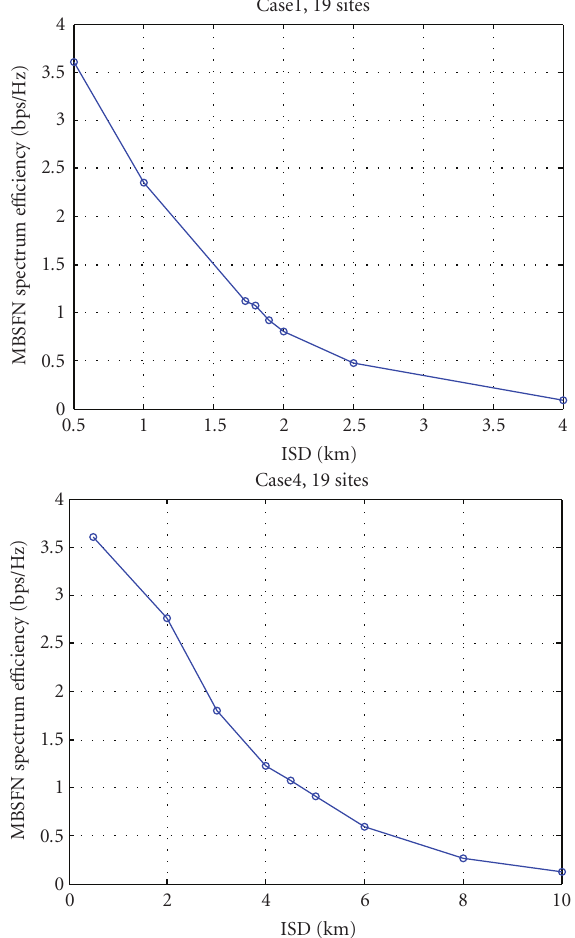
Figure 22: Broadcast capacity versus intersite distance.